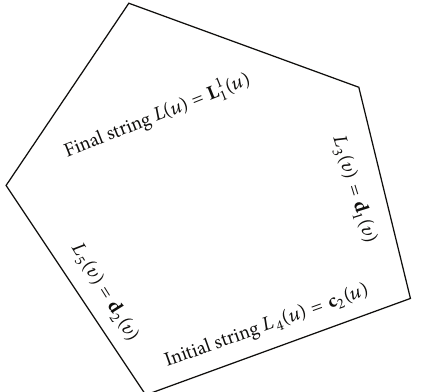
Figure 5: An initial string c 2 (𝑢) = 𝐿 4 (𝑢) with d 1 ( V ) = 𝐿 3 ( V ) and d 2 ( V ) = 𝐿 5 ( V ) modeling the time evolution of its ends and the combination 𝐿(𝑢) contains the two final strings 𝐿